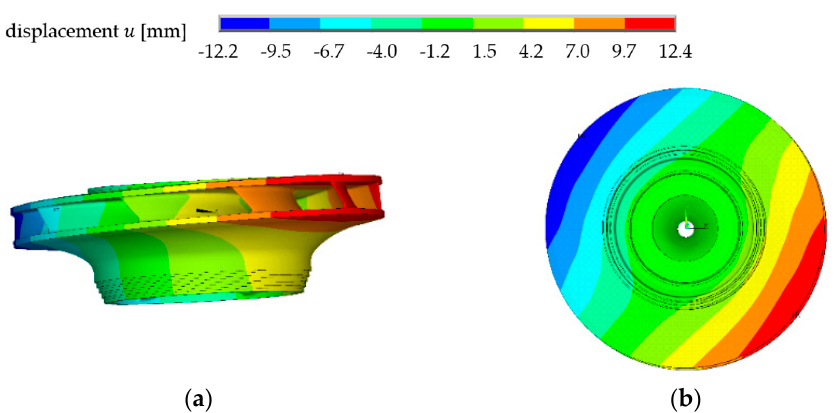
Figure 22. The dynamic stress amplitude of 1/4 VPF and VPF. ( a ) S3; ( b ) S5. The modal analysis was performed to tell whether the sudden rise of 1/4 VPF was caused by resonance. The natural frequency of first mode is 95.95 Hz and the mode shape is shown in Figure 23. There is a nodal diameter in this mode shape, so it is usually marked as 1ND [28]. This is a common mode shape for most runners and other structure similar with the disc [29,30]. The rotating rate at TP7 is 489.24 rpm, and the value of 1/4 VPF is 32.62 Hz, far from 95.95 Hz. Therefore, the steeply increase of dynamic stress at TP7 is not the contribution of resonance.